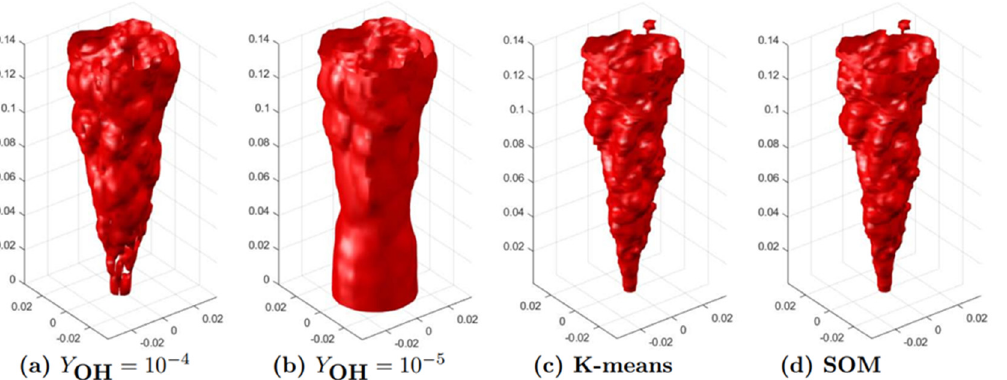
( a ) HM1; ( b ) Sandia Flame D.